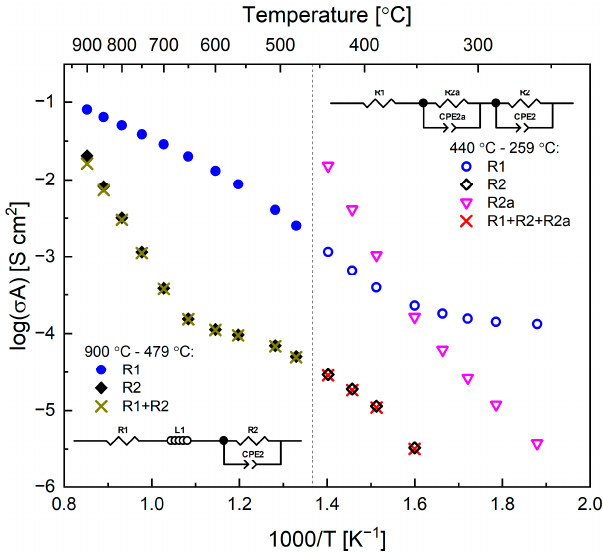
Figure 8. Temperature dependence of the derived components of the resistance date measured for Pr005|LSGM|Pr005 symmetrical cell in air. Table 4. Activation energy values for the resistance components of Pr005|LSGM|Pr005 cell. Resistance in the